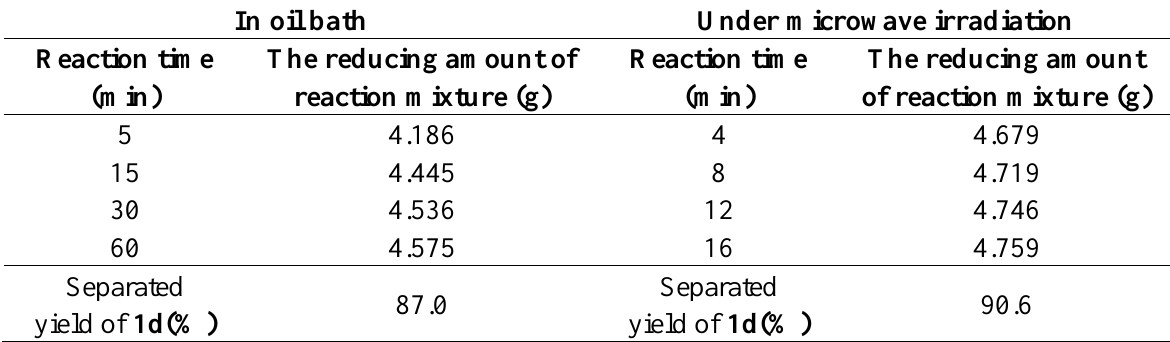
Table 5. Effect of reaction time on the